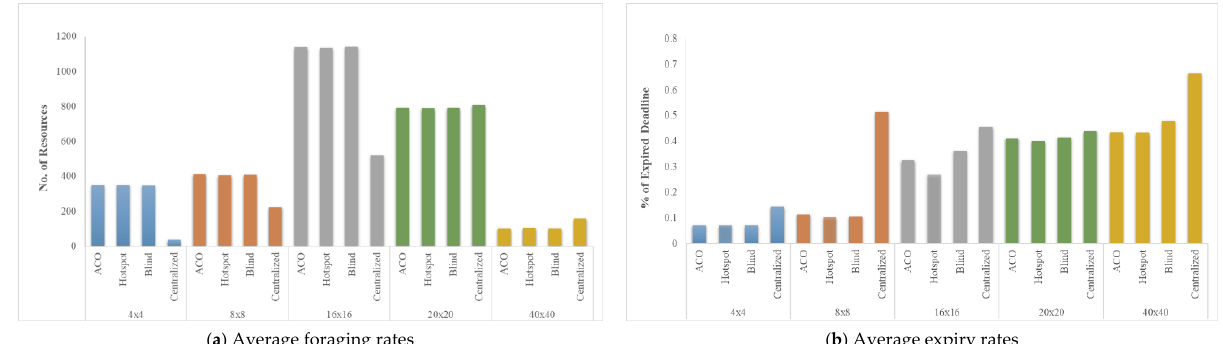
Figure 6. Average flexibility of the different methods in terms of the ( a ) foraging and ( b ) expiry rates.